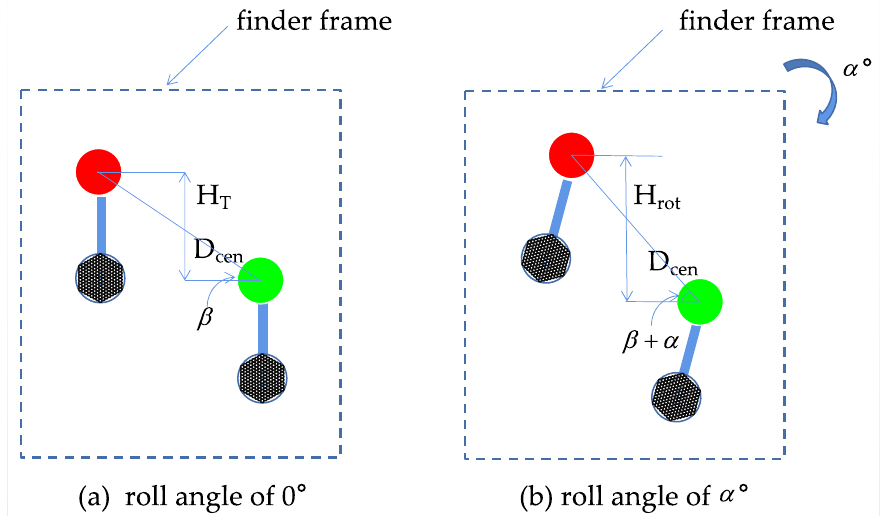
Figure 11. Schematic diagram of image deflection caused by camera deflection. The camera displacements in the transverse and vertical directions only change the position of optical target in the collected images, as shown in Figure 12, causing no devia- tions to the measurement. Similarly, the pitch angle and yaw angle of the camera do not lead to image deflection. Their impacts on the measurement accuracy can be eliminated by expanding the monitoring range of the camera and using an anti-distortion